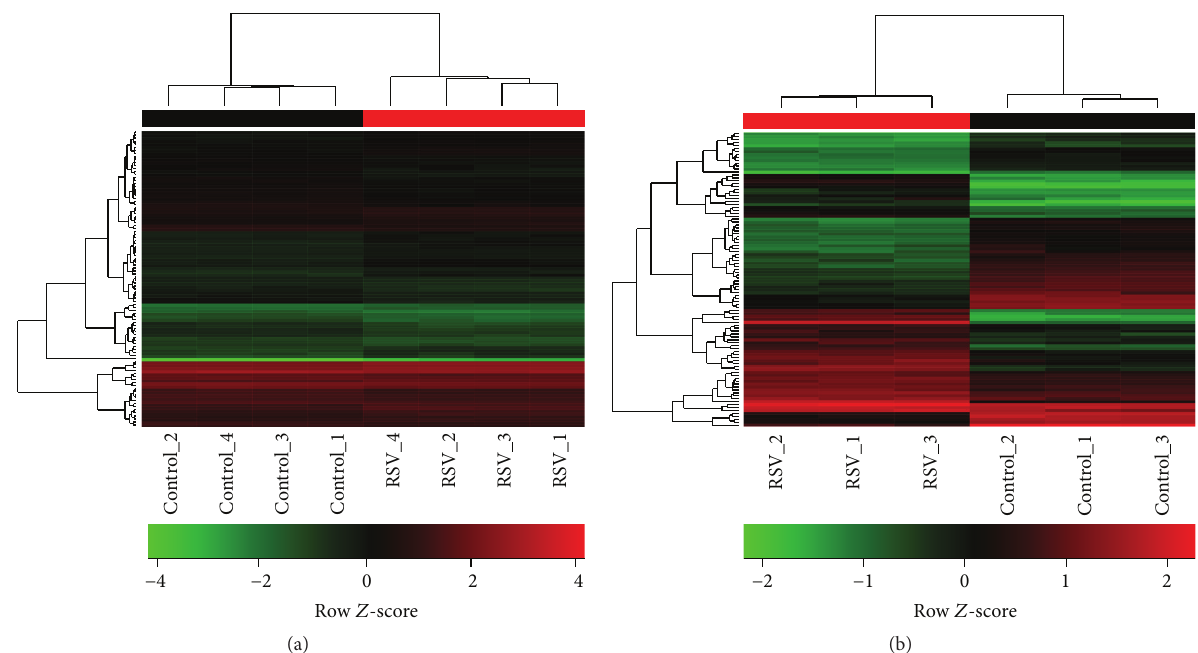
Figure 2: Transcriptional profiles of BEAS-2B cells infected with RSV for 4 h. (a) Hierarchical clustering of differentially expressed genes from dataset GSE3397. (b) Hierarchical clustering of differentially expressed genes from dataset GSE6802. Row 𝑍 -scores were calculated based on normalized expression data. The colors from green to red represent the transition of decreased to increased expression.